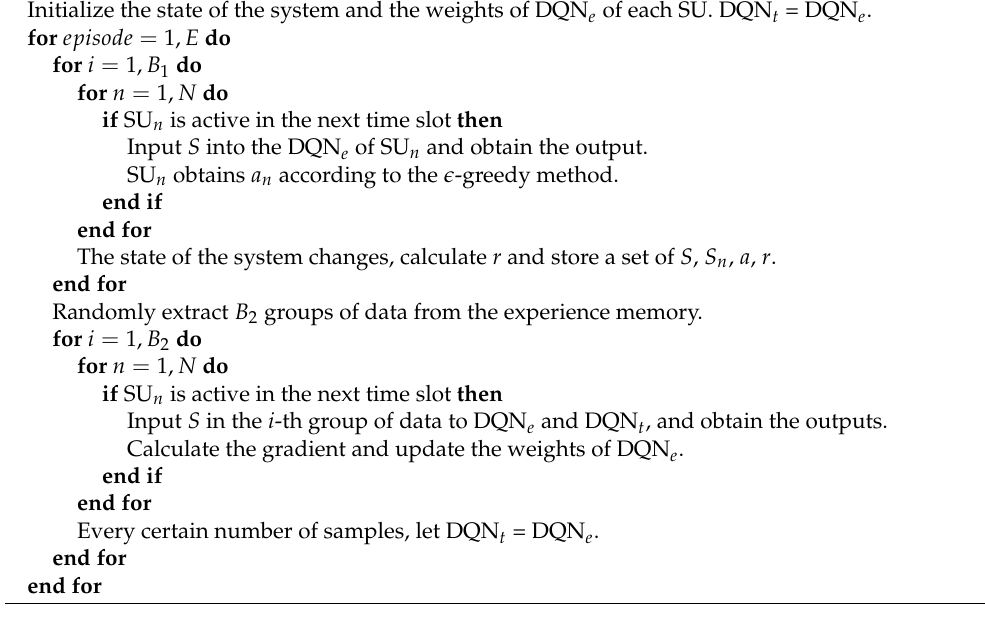
Algorithm 1 Training Algorithm of the DQN Method